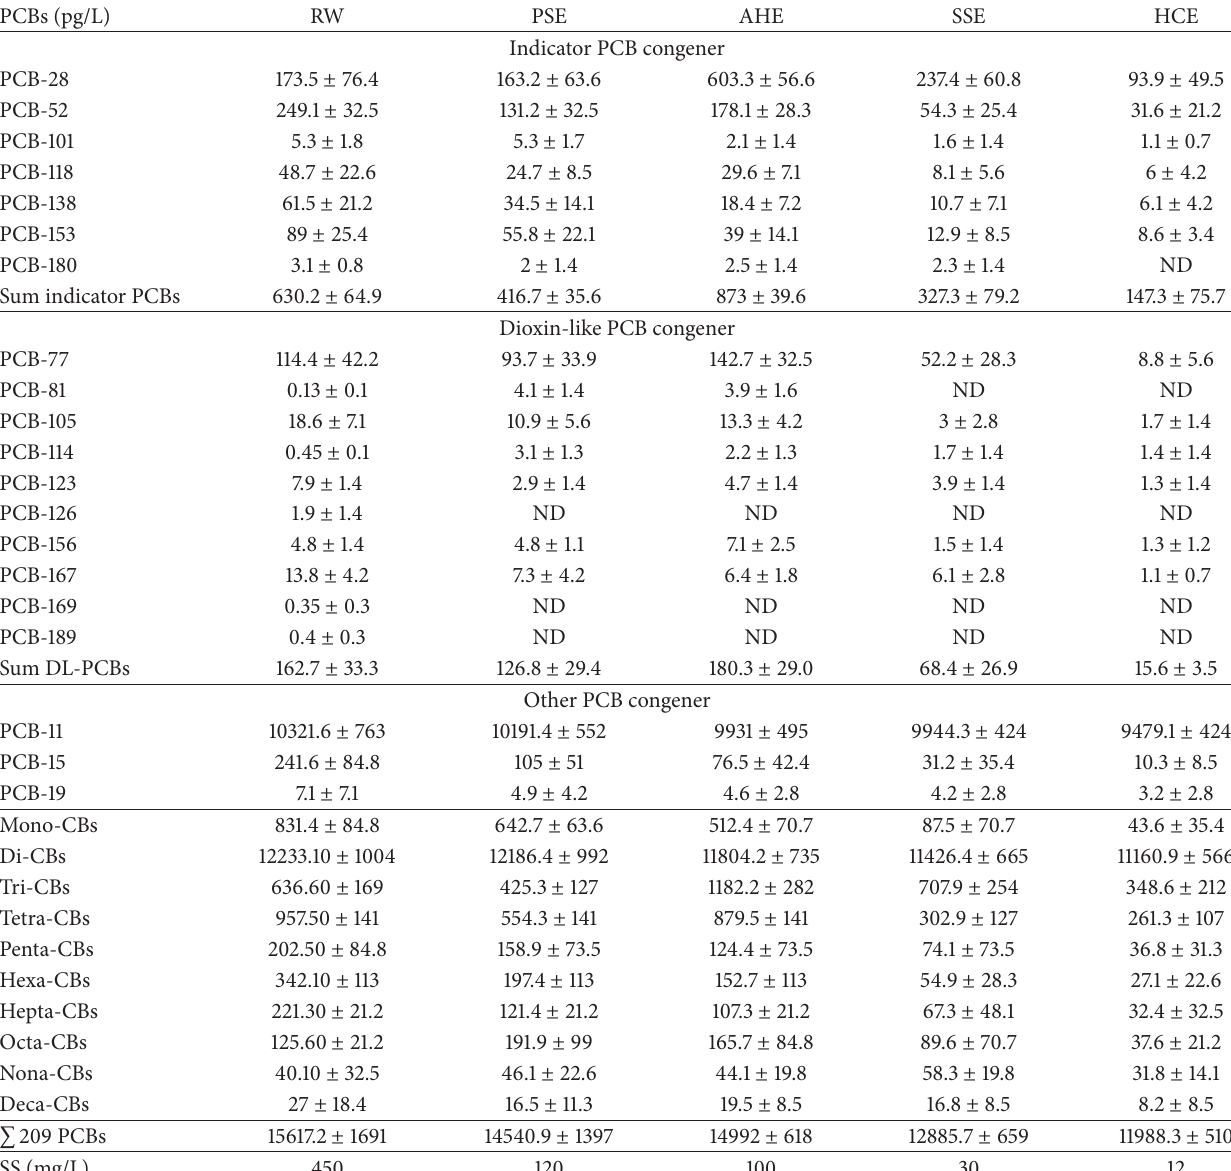
Table 2: The concentrations (means ± SD) of PCBs in wastewater of each treatment stage at the